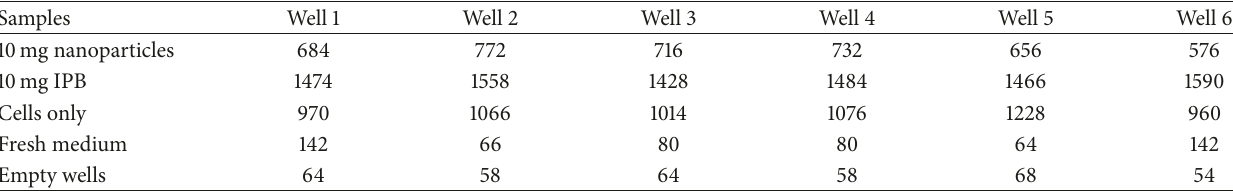
Table 2: Measurement of dead cells (step